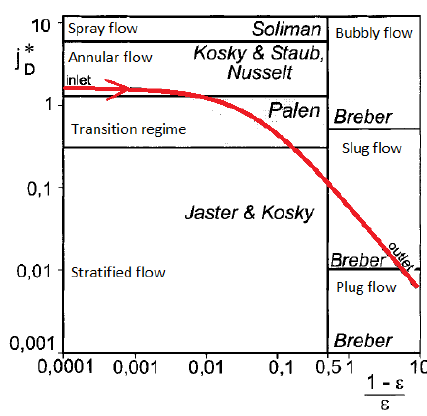
Fig. 4 . Tandon's flow regime map